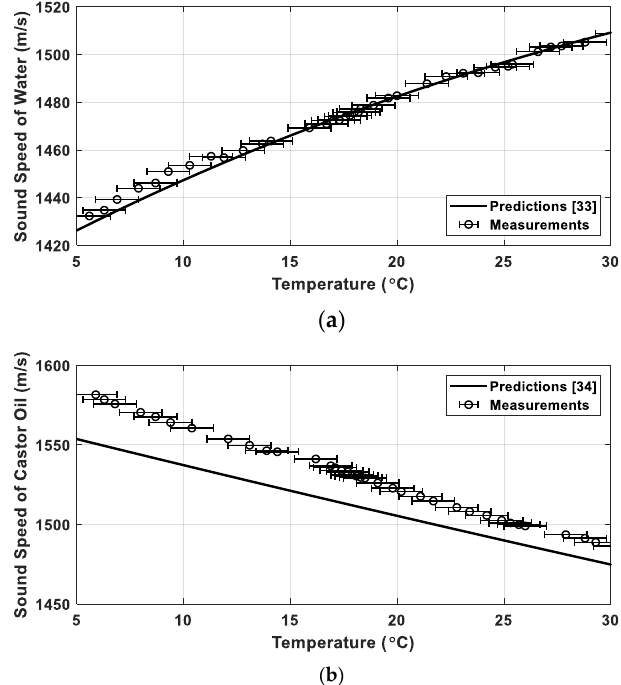
Figure 2. ( a ) Measured sound speeds in water (circles) as a function of temperature and a comparison with the predictions obtained by an empirical formula (solid line) and ( b ) those for castor